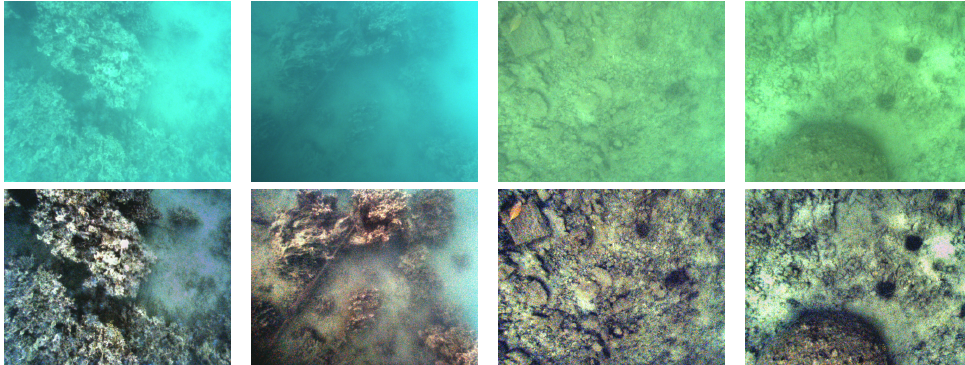
Figure 8. The hazy examples were chosen from the Stereo Underwater Image Dataset [26]. Although the dataset provided paired images taken by stereo cameras, we treat the images as if they were taken by monocular cameras in our work. Top row: hazy images; Bottom row: corresponding enhanced images.